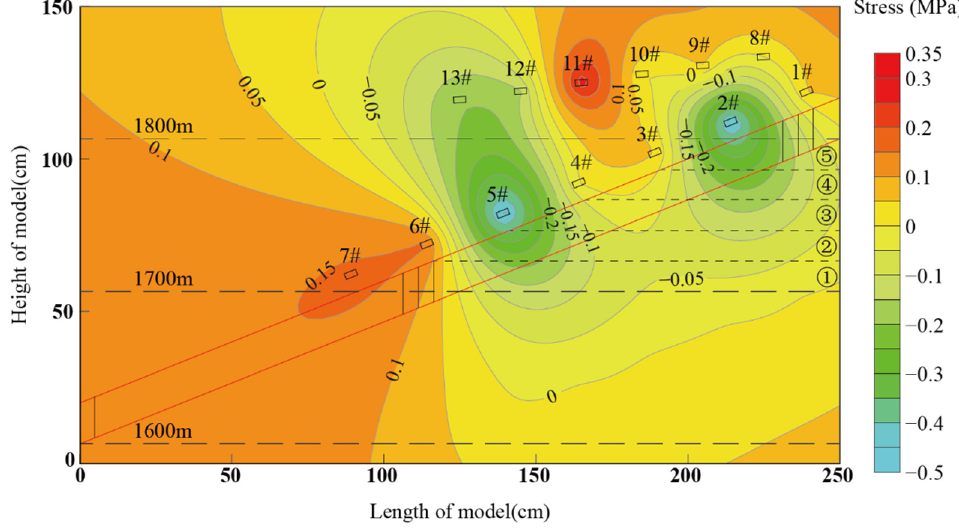
Figure 12. Contour of stress increment of fill mass excavation to the second sublevel.